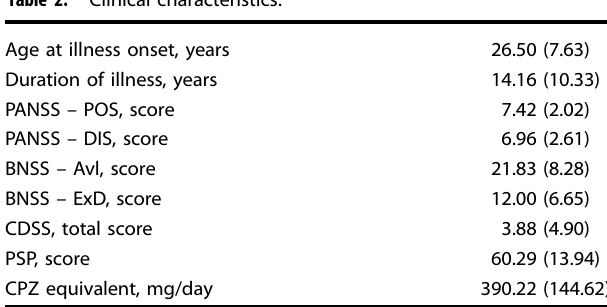
Table 2. Clinical characteristics.